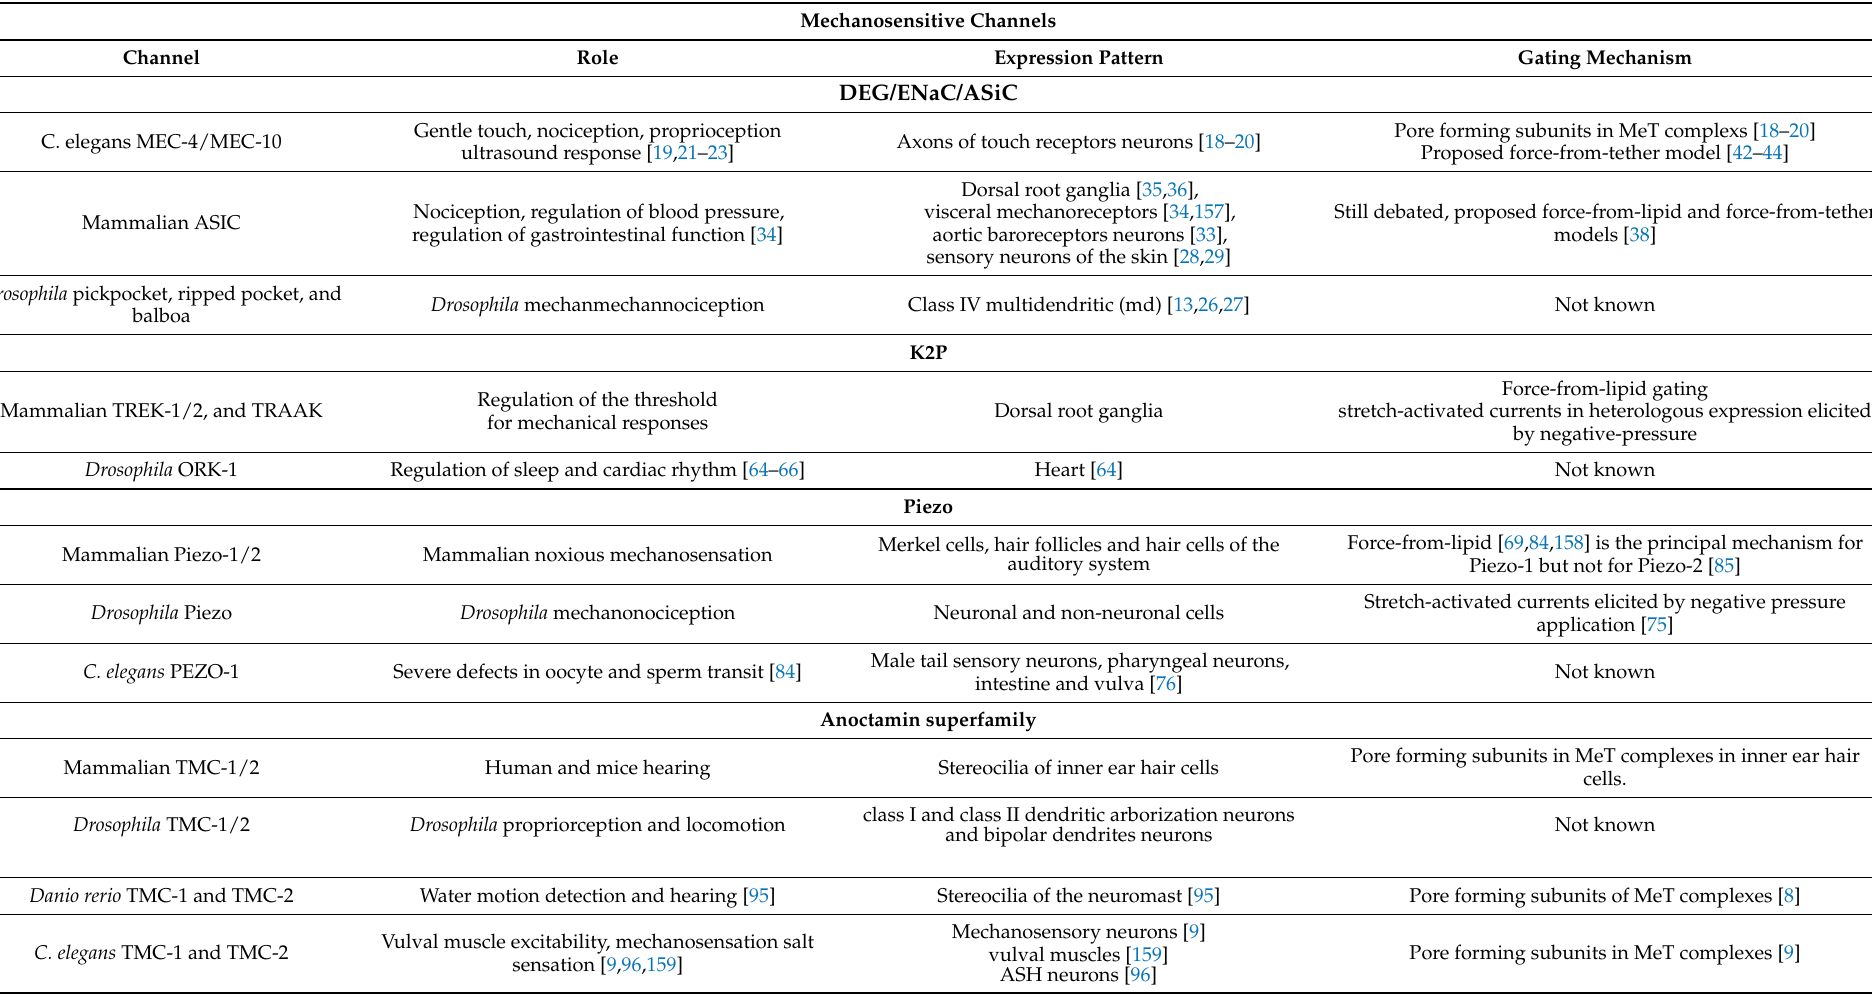
Table 1. List of mechanosensitive ion channels expressed in